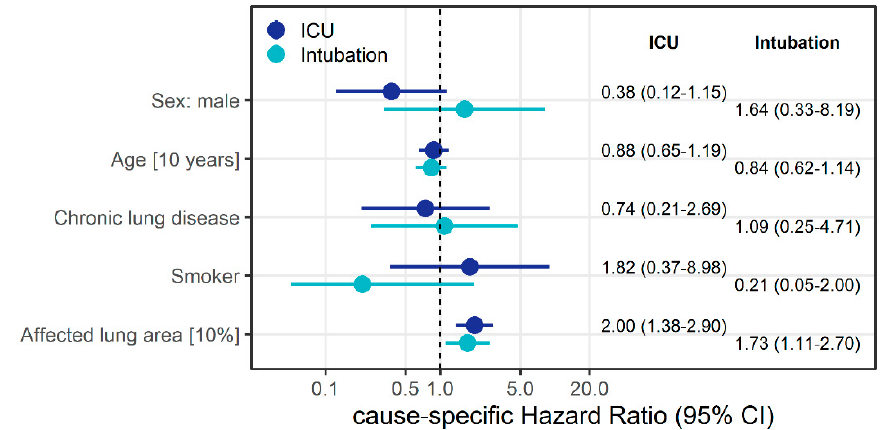
Figure 3. Cause-specific hazard ratio estimates along with 95% confidence intervals (CI) derived from competing risks Cox regression models to identify factors associated with the instantaneous risk of ICU admission and intubation, respectively. Event of interest was intubation; discharge and death were treated as competing risks. All displayed variables were included in the model.